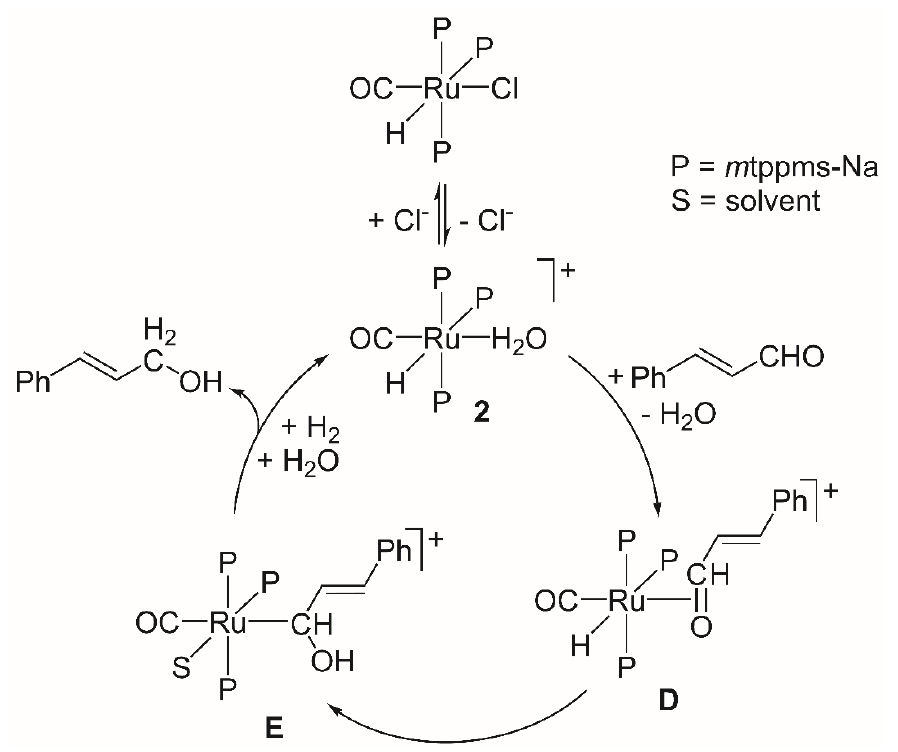
Figure 12. Suggested mechanism of cinnamaldehyde hydrogenation catalyzed by [RuHCl(CO)( m tppms ‐ Na) 3 ], 1 .